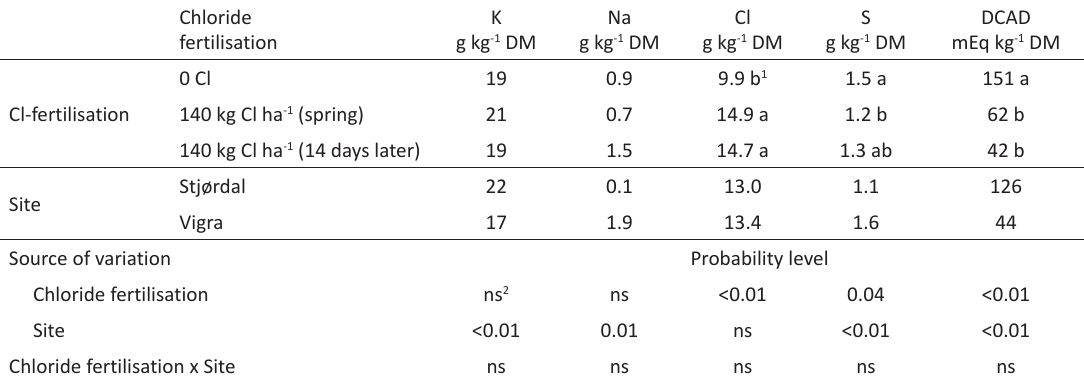
Table 4. Experiment 3: Mineral concentrations and dietary cation-anion difference (DCAD) at the first cut. Effects of calcium chloride applied at different times in spring to leys dominated by timothy and meadow fescue. Two field trials in one year. Chloride fertilisation